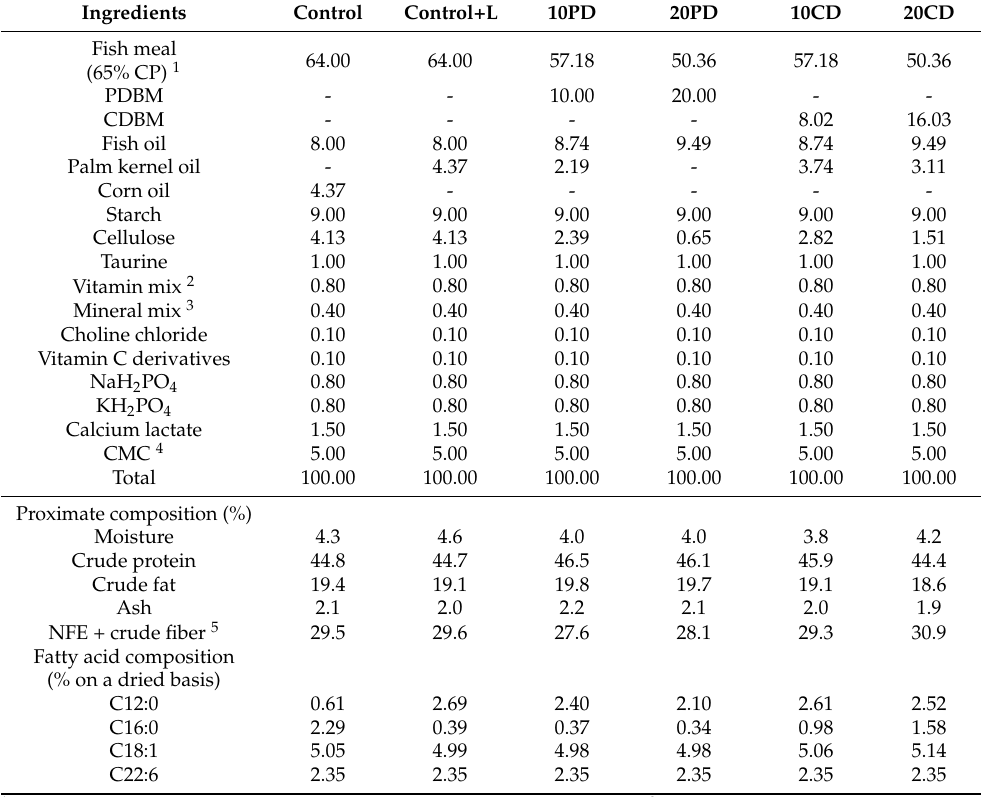
Table 2. Formulation of experimental diets in feeding trial 2.